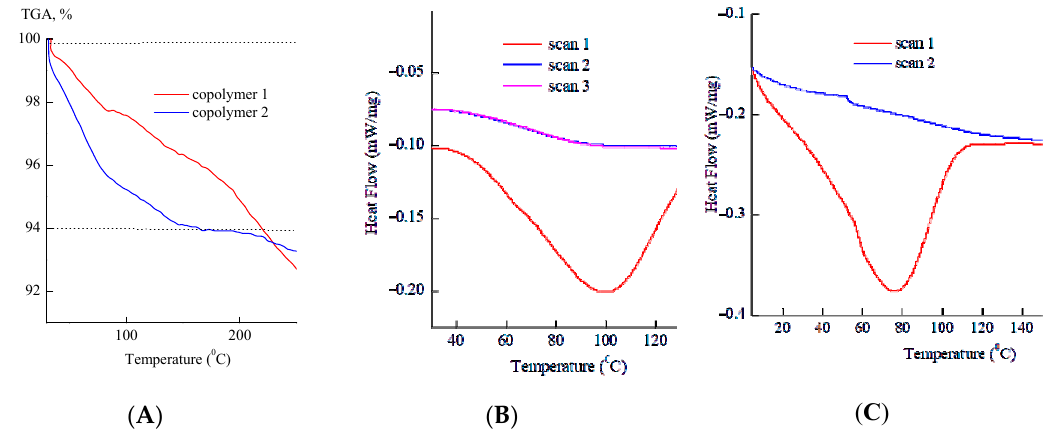
Figure 4. ( A ) Curves of the TGA and ( B , C ) DSC of copolymers 1 and 2.